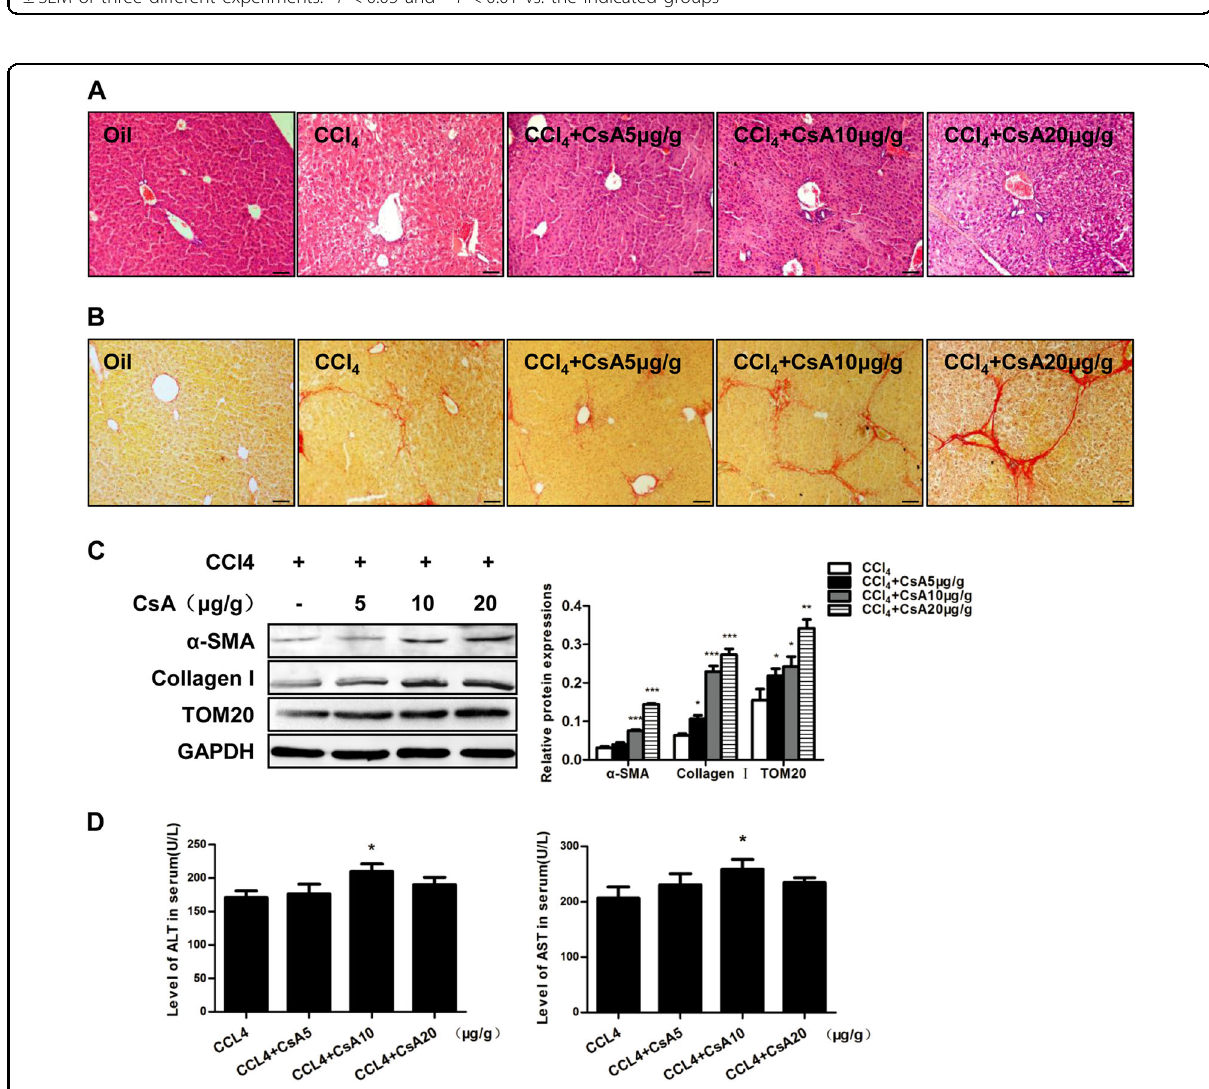
Fig. 4 Inhibition of mitophagy aggravates hepatic fi brosis in mice. a H&E staining of liver sections from mice; n = 6 per group; scale bar, 50 μ m. b Sirius red staining of collagen in mouse liver sections; n = 6 per group; scale bar, 50 μ m. c Representative western blots of TOM20, collagen I and α -SMA. Bar graph represents the mean ± SEM of three different experiments. * P < 0.05; ** P < 0.01; and *** P < 0.001 vs. the indicated groups. d Serum levels of ALT and AST in the indicated mice. Bar graph represents the mean ± SEM; n = 6 per group. * P < 0.05 vs. the indicated